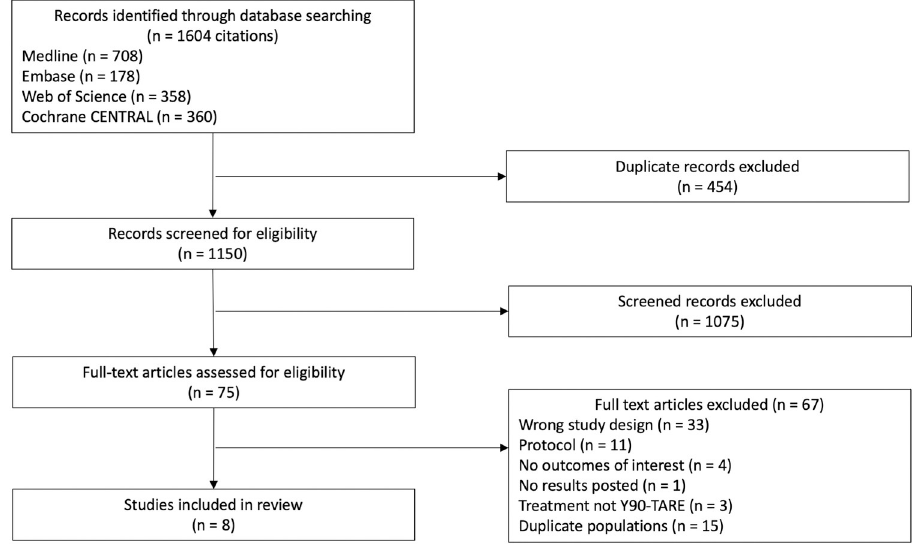
Fig 1. PRISMA flow diagram. The PRISMA flow diagram for the systematic review detailing the database searches, the number of citations screened, and the full texts retrieved.